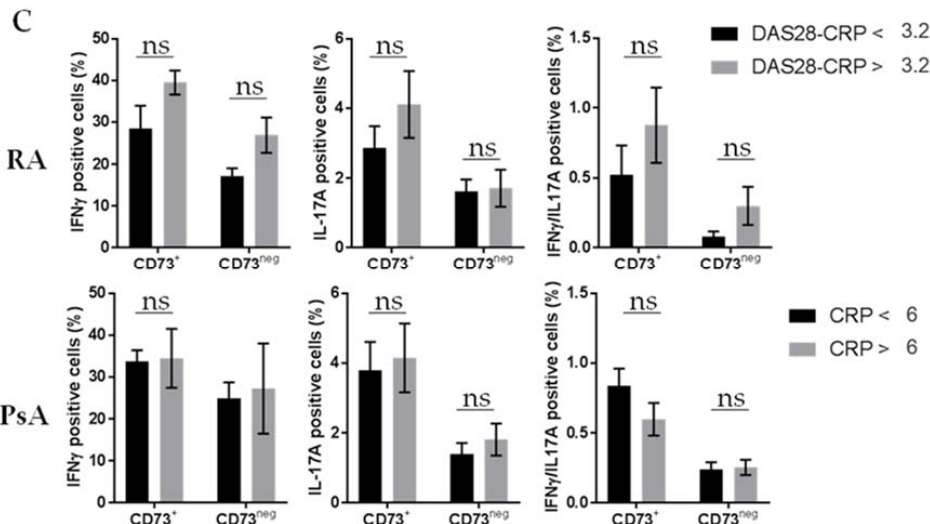
Figure 2. Polyfunctionality of Te ff is not altered in RA and PsA patients but there are less CD73 + cells identified in IL-17A / IFN- γ secreting Te ff . ( A ): SPICE ® representation of the cytokines secreted by either CD73 + or CD73 neg Te ff from peripheral blood of HD, or untreated RA and PsA patients. ( B ): CD73 expression on Te ff according to their secretion of IFN- γ , IL-17A and IL-22 in peripheral blood of HD or untreated RA and PsA patients. ( C ): IFN- γ and IL-17A mono- or co-production by Te ff according to their CD73 expression in untreated RA and PsA patients stratified on DAS28-CRP score and CRP seric level respectively. ( B , C ): ANOVA-2. * p < 0.05, ** p < 0.001, *** p <